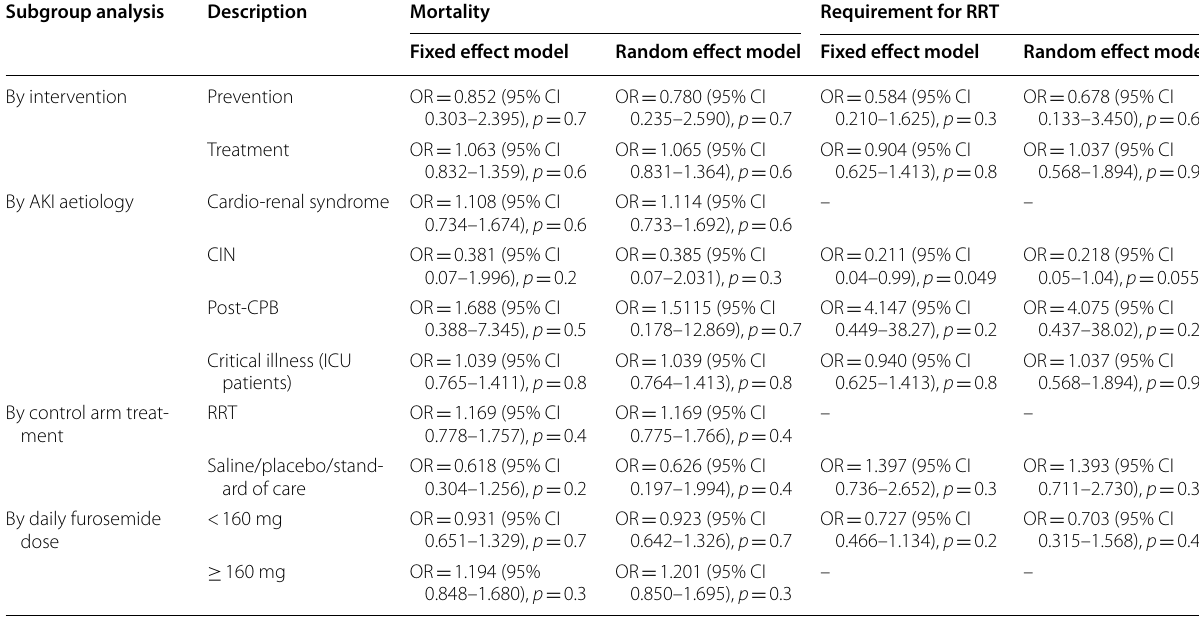
Table 3 Subgroup